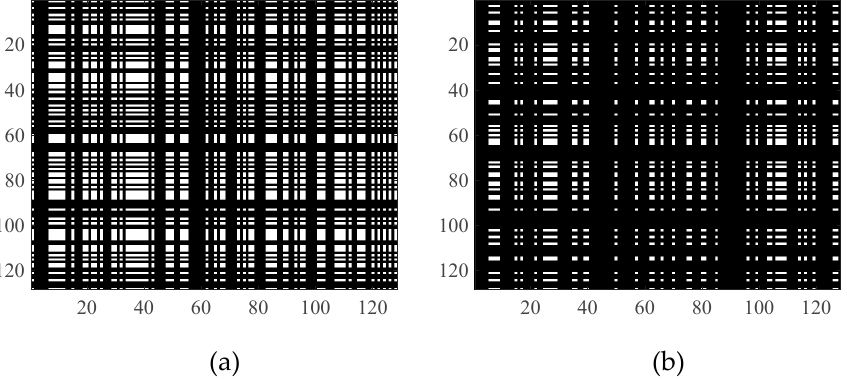
Figure 7. The missing data pattern of ( a ) 75% loss rate and ( b ) 90% loss rate.